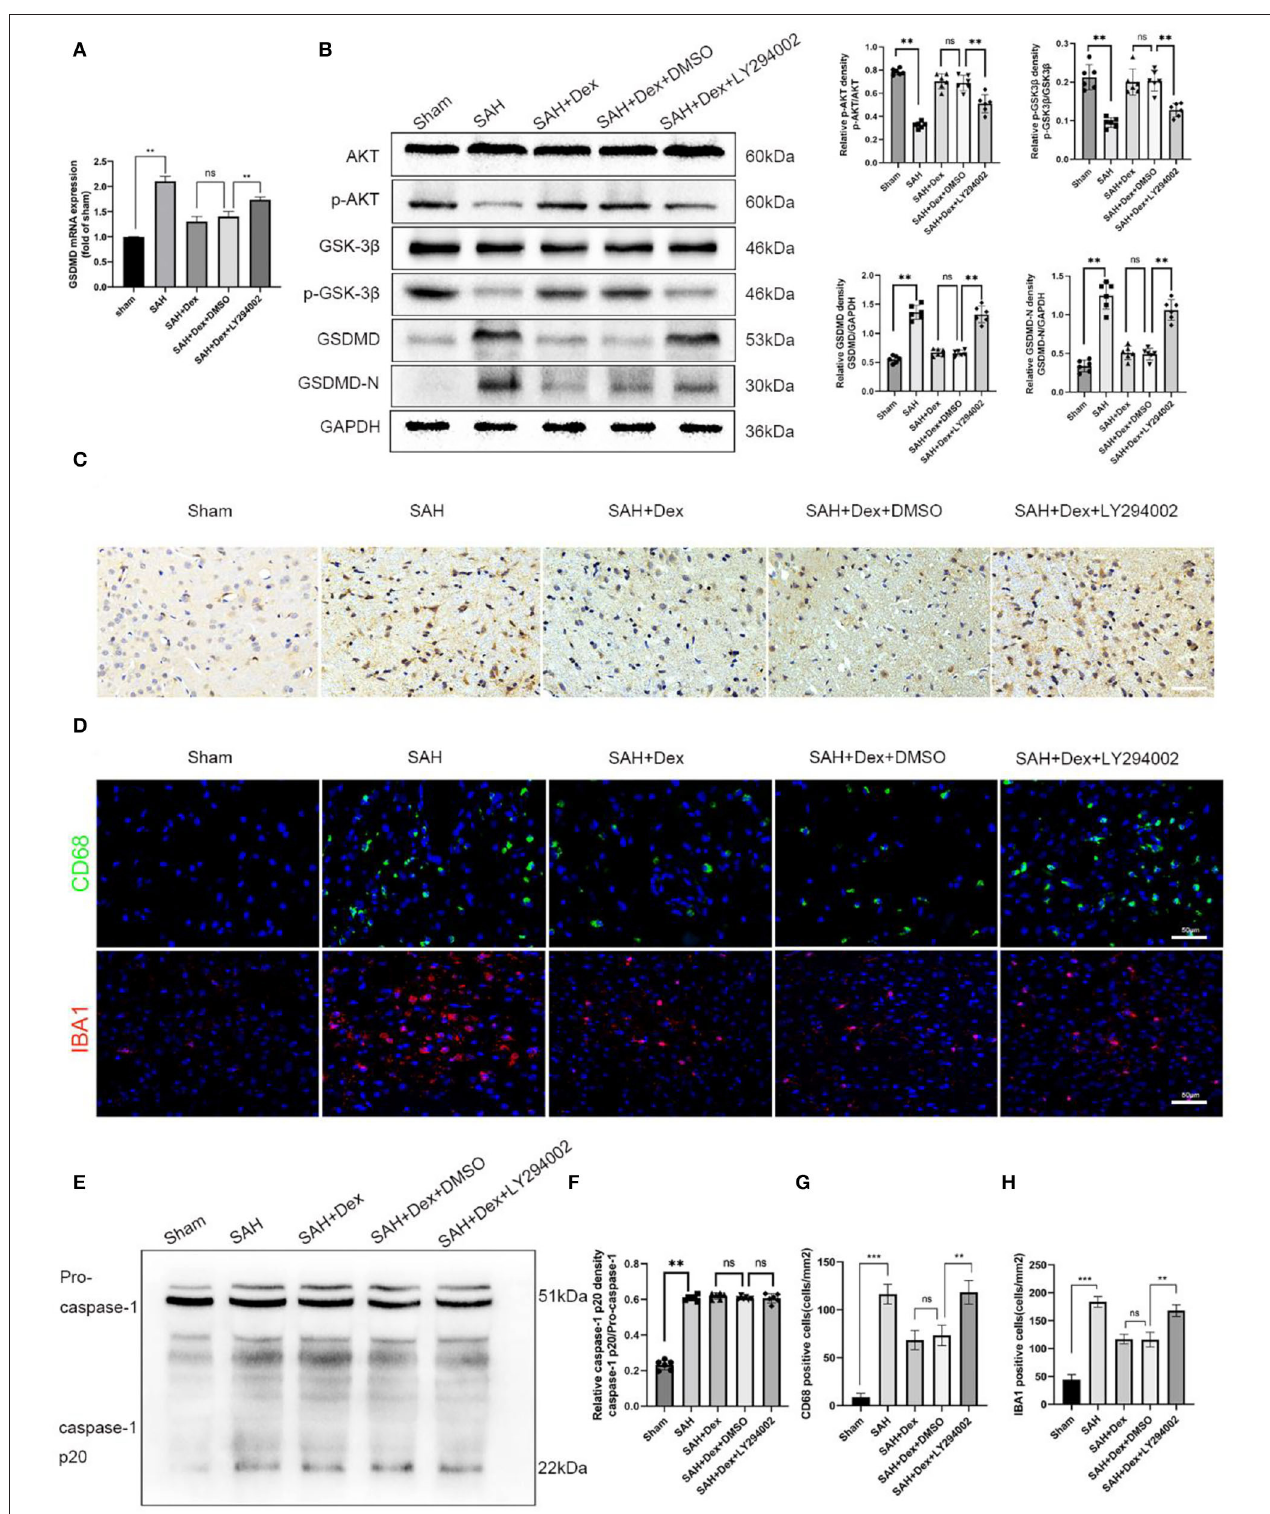
FIGURE 8 | LY294002 inhibited Dex-induced upregulation of the PI3K/AKT/GSK3 β pathway-related molecules, p-AKT, p-GSK3 β at 24h post-SAH and abolished the positive effect of Dex on the reduction of GSDMD and GSDMD-N. (A) Real-time RT-qPCR assay of GSDMD, n = 6 in each group. (B) Representative western blot images and quantitative analysis of western blot; n = 6 in each group; data are expressed as the mean ± SD. ** p < 0.01. (C) Representative images of